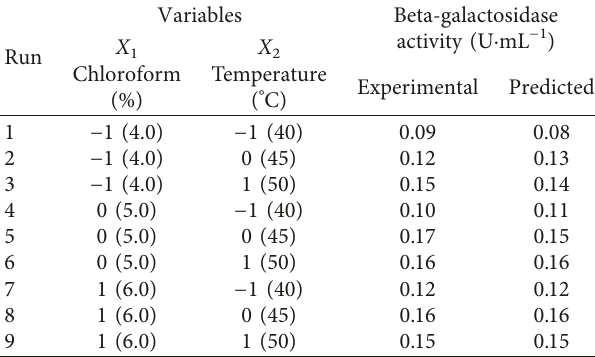
Table 3: The Box–Behnken design used to determine the effect of chloroform and temperature on the enzymatic activity of extracted beta-galactosidase of Aspergillus orzyae CCT 0977.